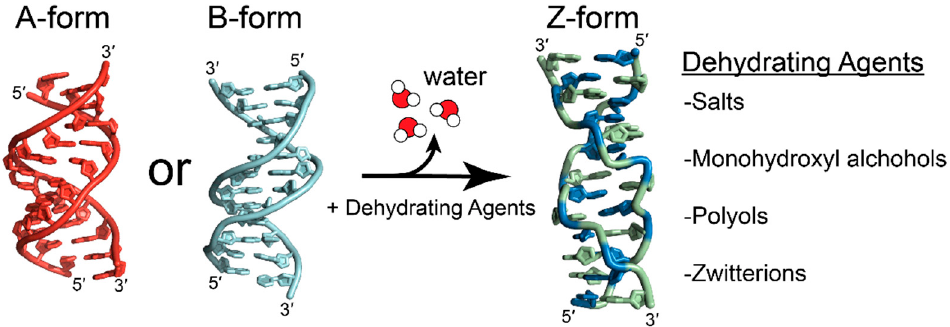
Figure 11. Dehydrating conditions favor the Z-conformation. Addition of dehydrating chemicals, such as salts, alcohols, and osmolytes favors the Z-conformation (green and blue, PDB: 4OCB [49]) over the right-handed A-RNA (red; PDB: 413D [48]) or B-DNA (cyan, PDB: 6CQ3) conformations due to the increased efficiency of hydrating the closely spaced phosphate backbones in the Z-conformation.